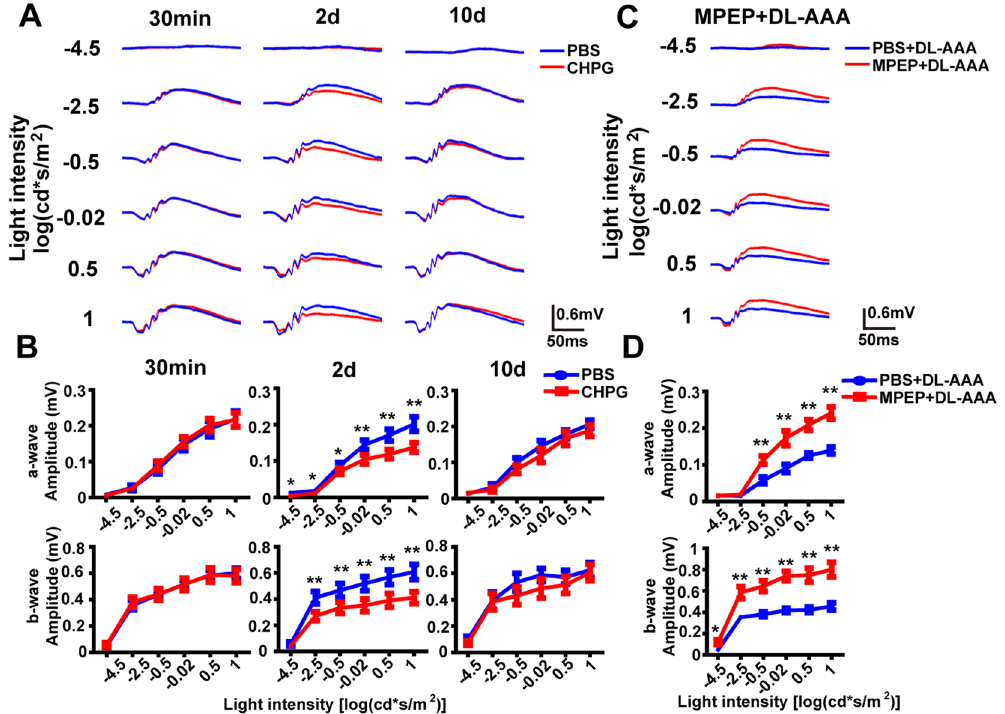
Figure 3. Effects of CHPG and MPEP + DL-AAA on the ERG. (A ) Example ERG waveforms recorded from CHPG treated eyes ( red ) and PBS-injected eyes ( blue ) at 30 min, 2 days and 10 days post-injection. ( B ) Top row: Average stimulus-response curves for a-wave amplitude in CHPG-treated and PBS-treated eyes at 30 min, 2 days and 10 days post-injection (n = 6, 11, 6). Bottom row: The same for b-wave amplitude. ( C ) Representative ERG waveforms for the MPEP + DL-AAA group ( red ) and PBS + DL-AAA group ( blue ) at 2 days after MPEP/ PBS injection (n = 6). ( D ) Top: Average stimulus-response curves for a-wave amplitude in DL-AAA + MPEP and DL-AAA + PBS treated eyes, 2 days after MPEP/PBS injection (n = 6 per data point). Bottom: The same for b-wave amplitude. Data are shown as mean ± SEM. * p < 0.05, ** p <